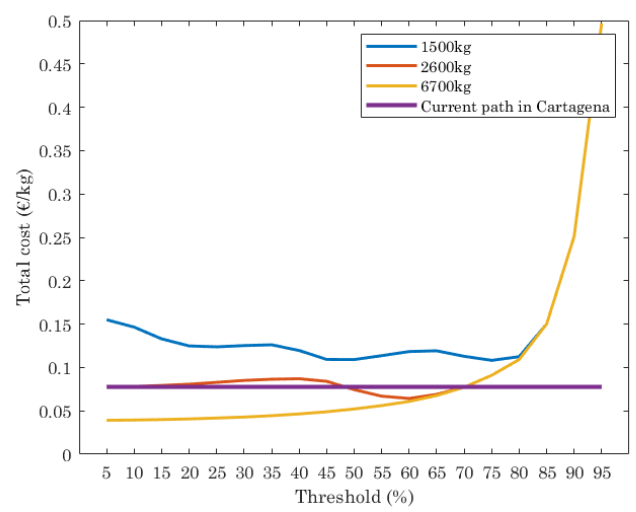
Figure 7. Cost (€ /kg), for the optimal paths given by ILP and the current path in